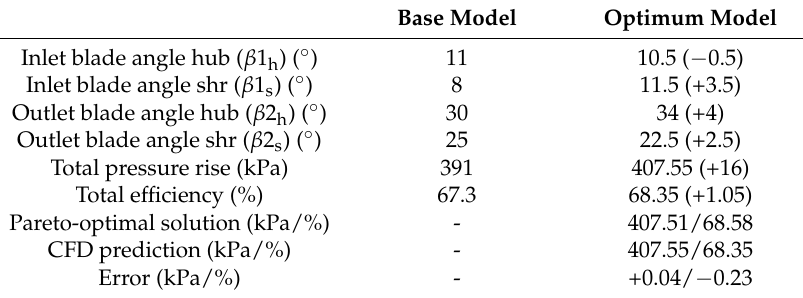
Table 4. Results of the multi-objective optimization for the 2nd impeller.